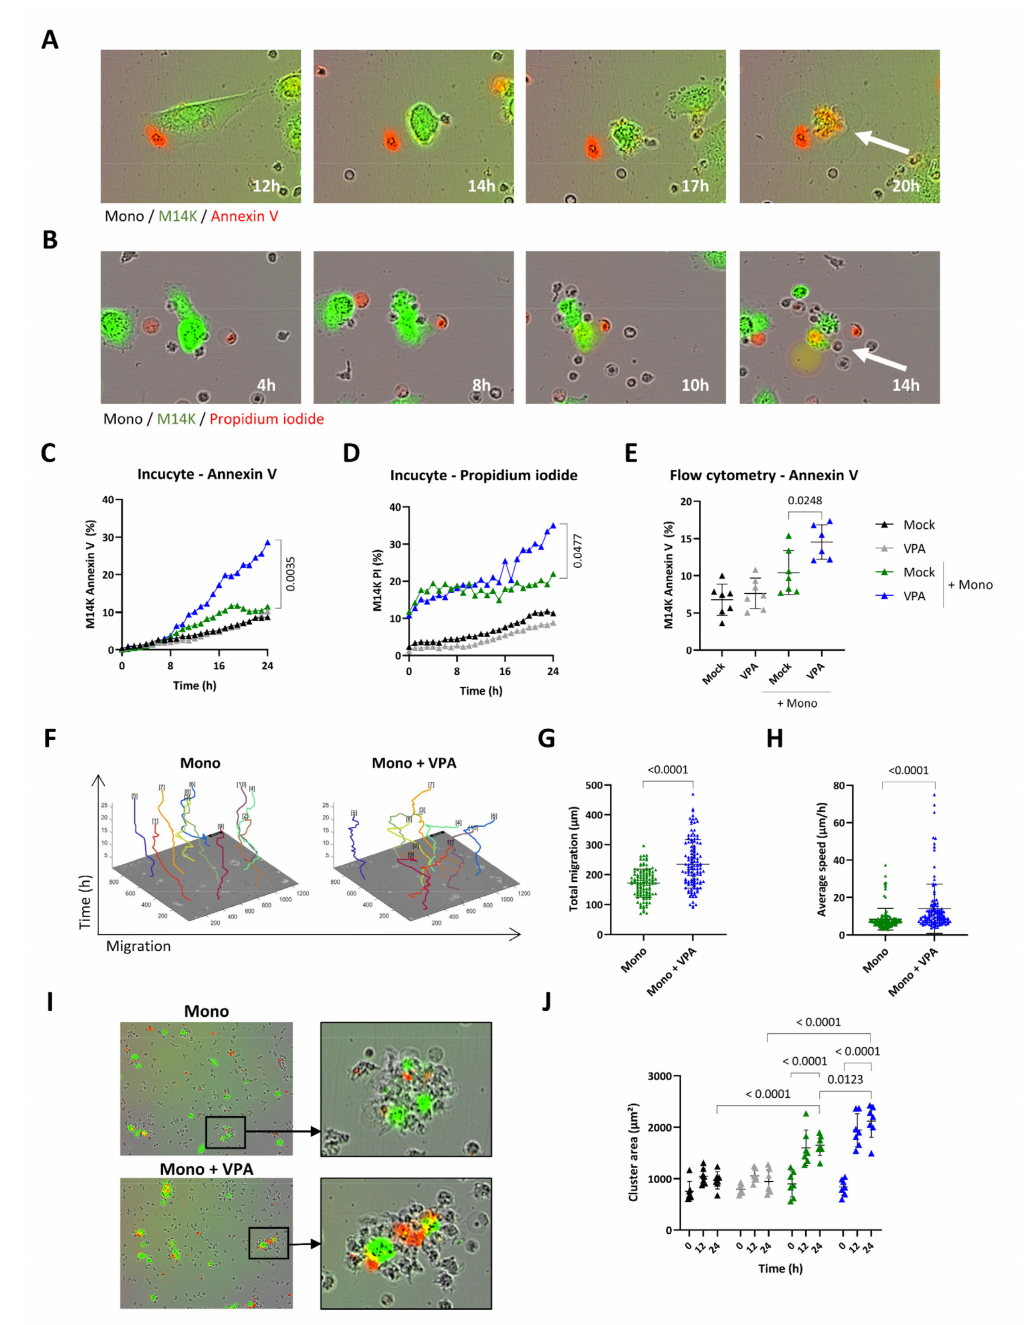
Figure 3. Effect of VPA on primary monocyte migration and cytotoxicity. ( A , B ) Blood-derived monocytes (Mock) were cocultured with CFSE-labeled M14K cells at a 20/1 ratio. Representative Incucyte kinetics upon labeling with annexin V-APC ( A ) or propidium iodide ( B ). ( C , D ) Single- cell imaging data from nine independent experiments were recorded by Incucyte. The graphs represent the mean percentages of CFSE-labeled M14K cells staining for annexin V ( C ) or propidium iodide ( D ). Statistical significance was evaluated using a one-way ANOVA with Tukey’s multiple comparison test. ( E ) After 24 h of coculture, cells were stained with annexin V-APC and analyzed